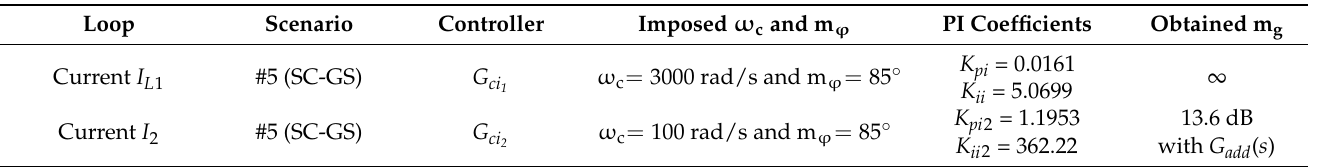
Table 6. Coefficients of PI regulators in the case of model